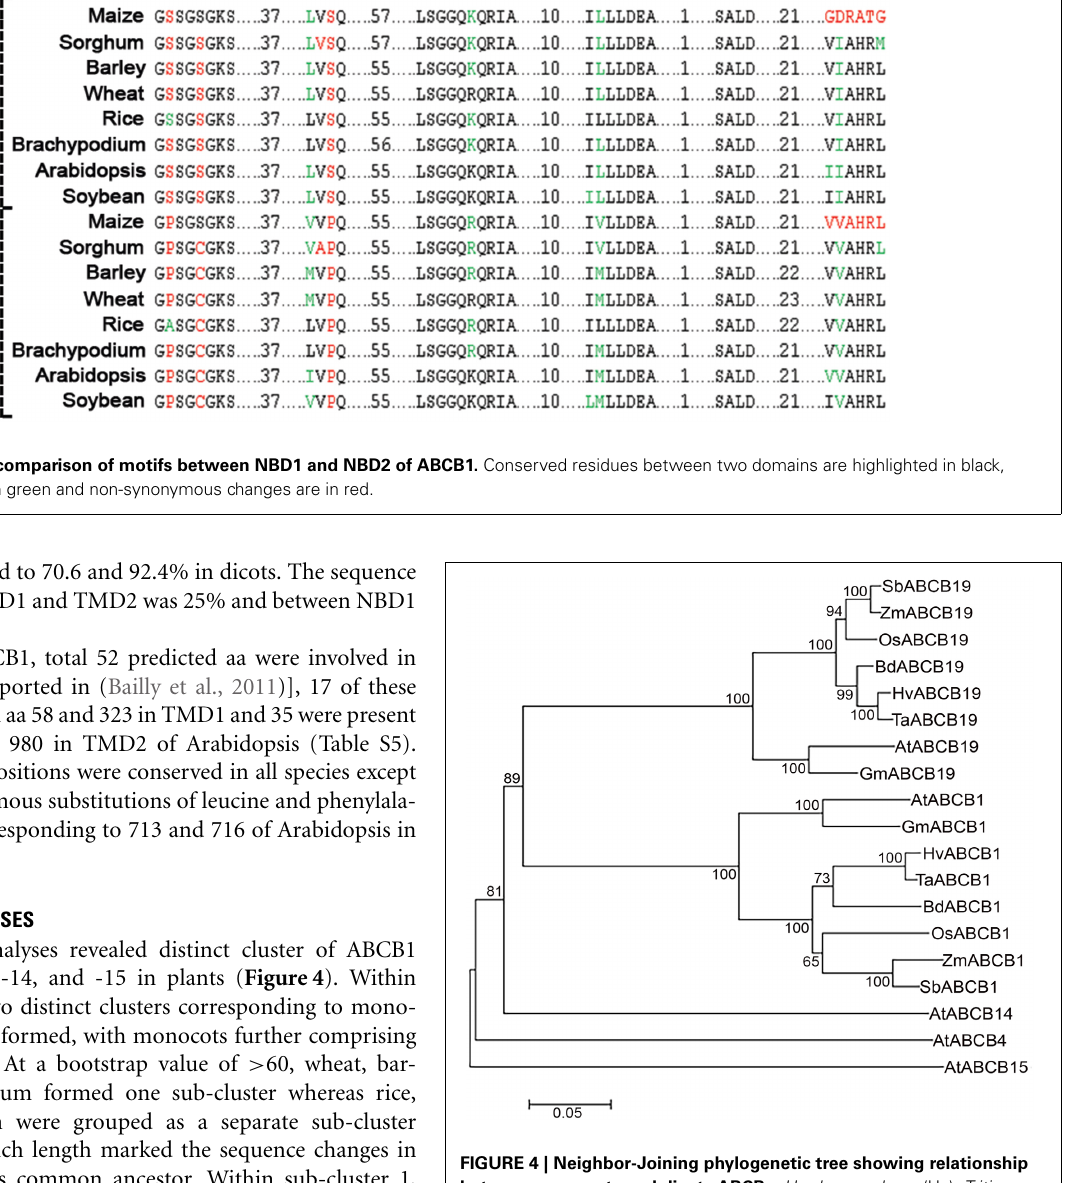
FIGURE 4 | Neighbor-Joining phylogenetic tree showing relationship between monocots and dicots ABCBs. Hordeum vulgare (Hv), Triticum aestivum (Ta), Brachypodium distachyon (Bd), Oryza sativa (Os), Zea mays (Zm), Sorghum bicolor (Sb), Arabidopsis thaliana (At), and Glycine max (Gm). Scale bar represents the number of amino acid changes per